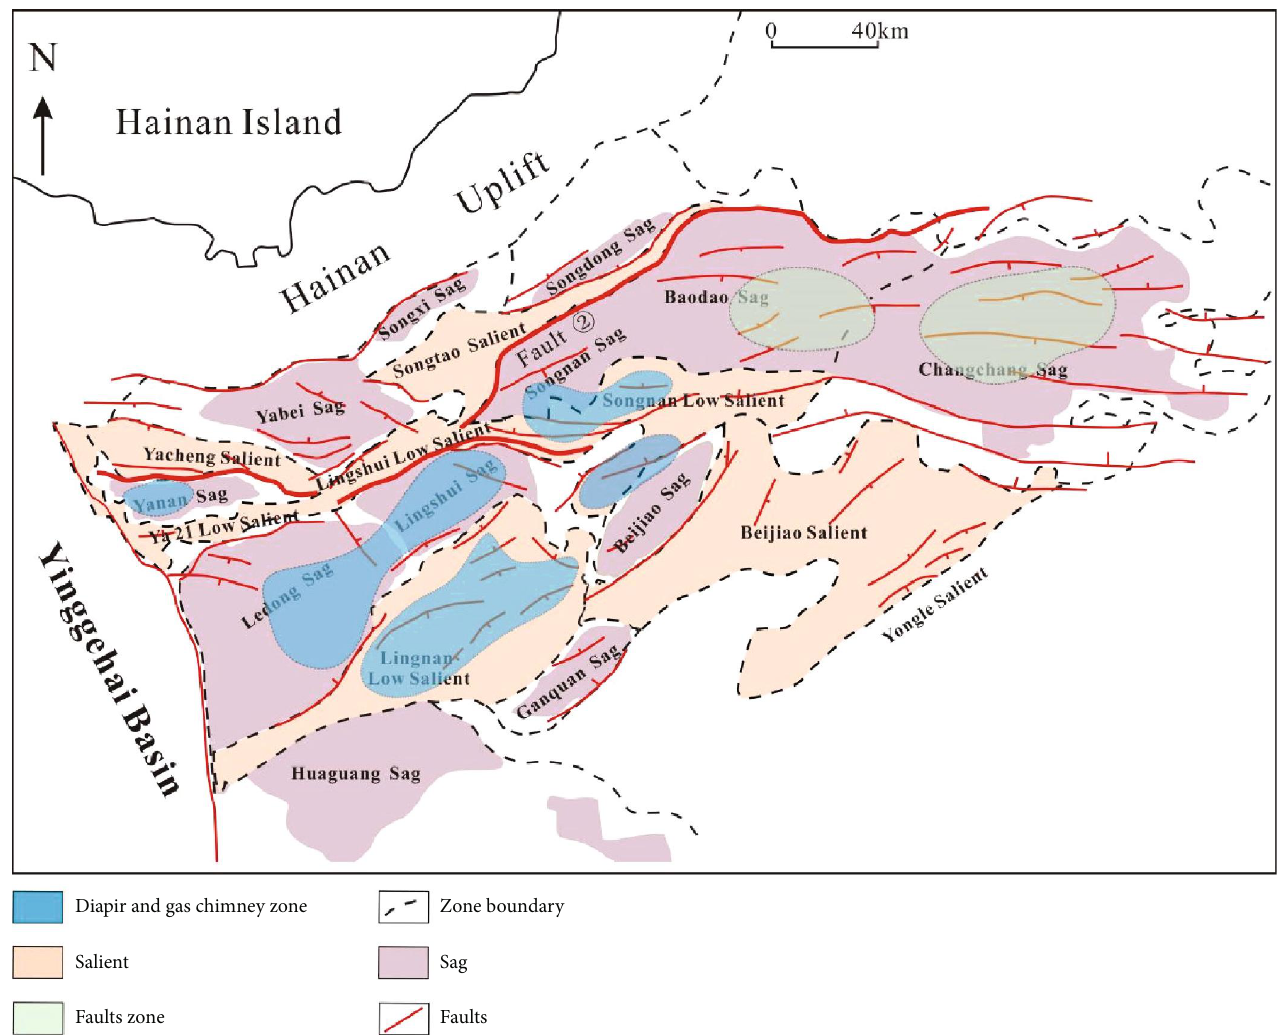
Figure 8: Distribution of the diapirs, gas chimneys, and fault structures in the QDNB (modi fi ed from [37,